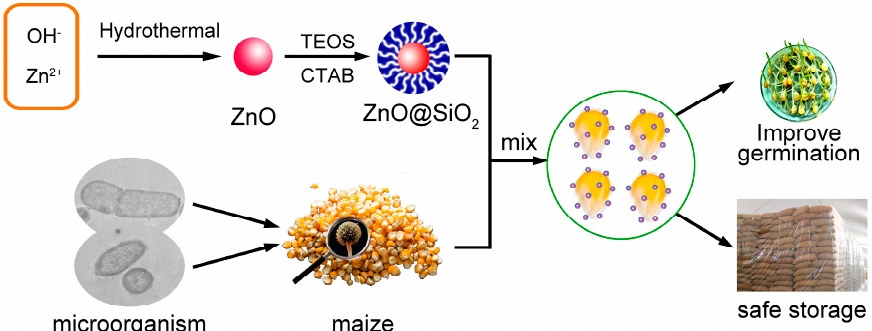
Figure 6. Schematic illustration of the synthesis and surface modification of ZnO and its application in inhibiting the growth of bacteria and fungi of maize [21].